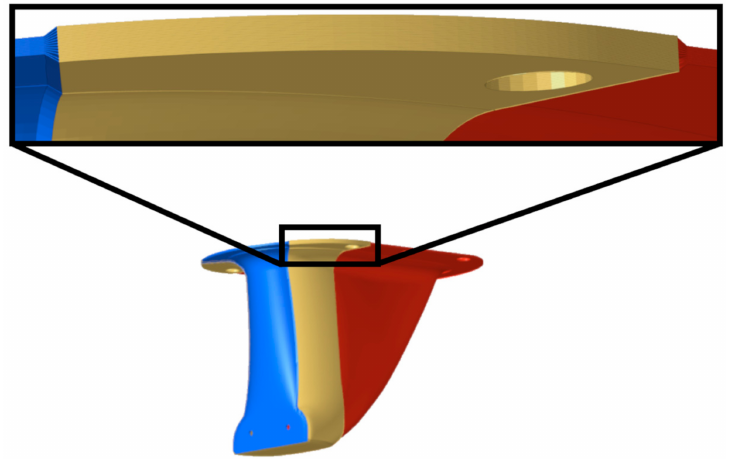
Figure 8. 12-ply laminate regions shown in yellow and red, 24-ply laminate overlap region shown in blue, and detailed view of finger joints for the partitioned structures